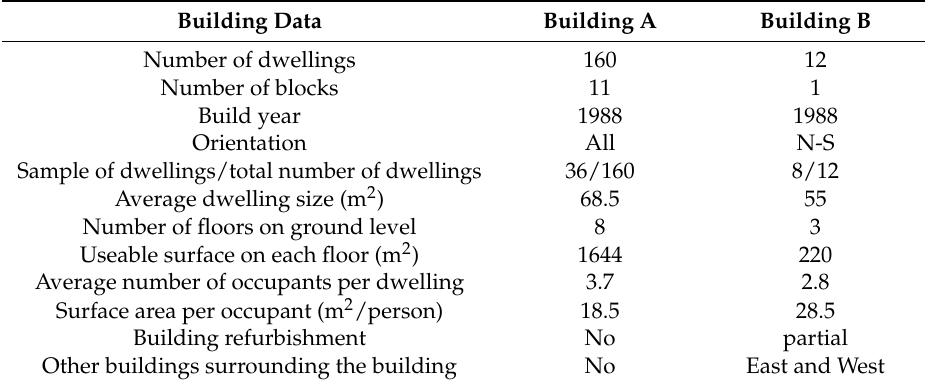
Table 2. General data of the buildings and residents.